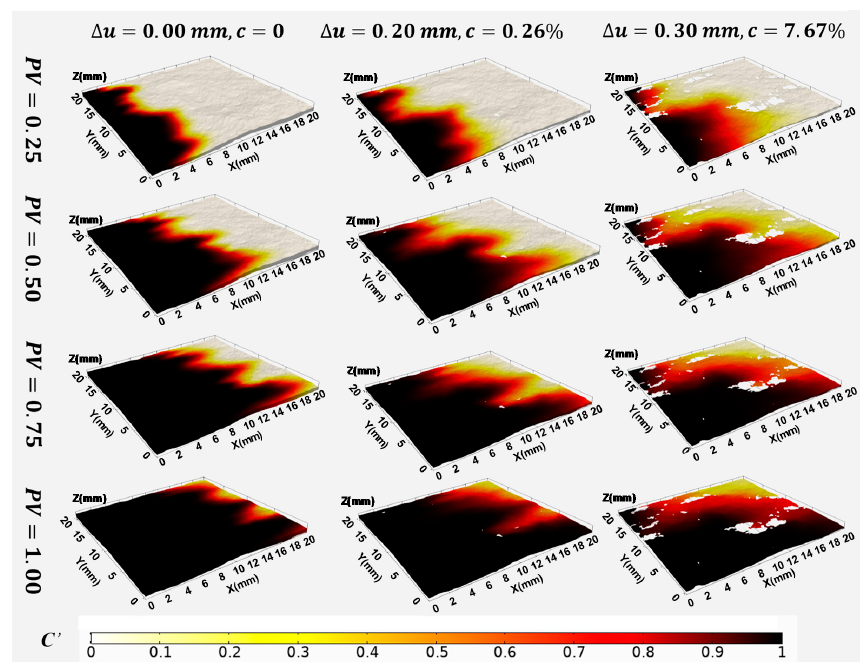
Figure 12. Evolutions of the concentration field for fractures of Δ u = 0.00, 0.20, and 0.30 mm at PV = 0.25, 0.50, 0.75 and 1.0 with H = 0.65.